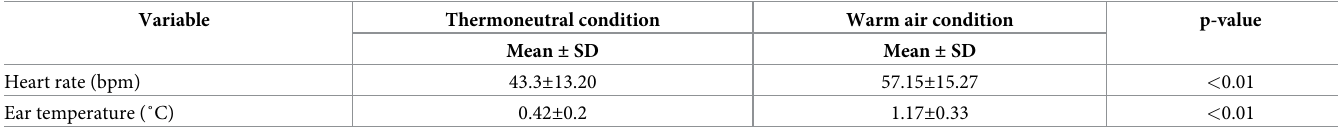
Table 3. The physiological response pre-post change before and after walking on a treadmill in thermoneutral and warm conditions.